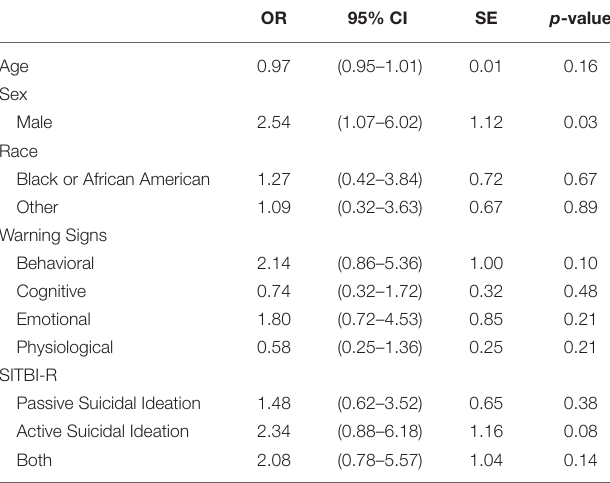
TABLE 3 | Results of multivariate logistic regressions of participant characteristics, warning signs, and suicidal ideation between gun owners and non-owners.